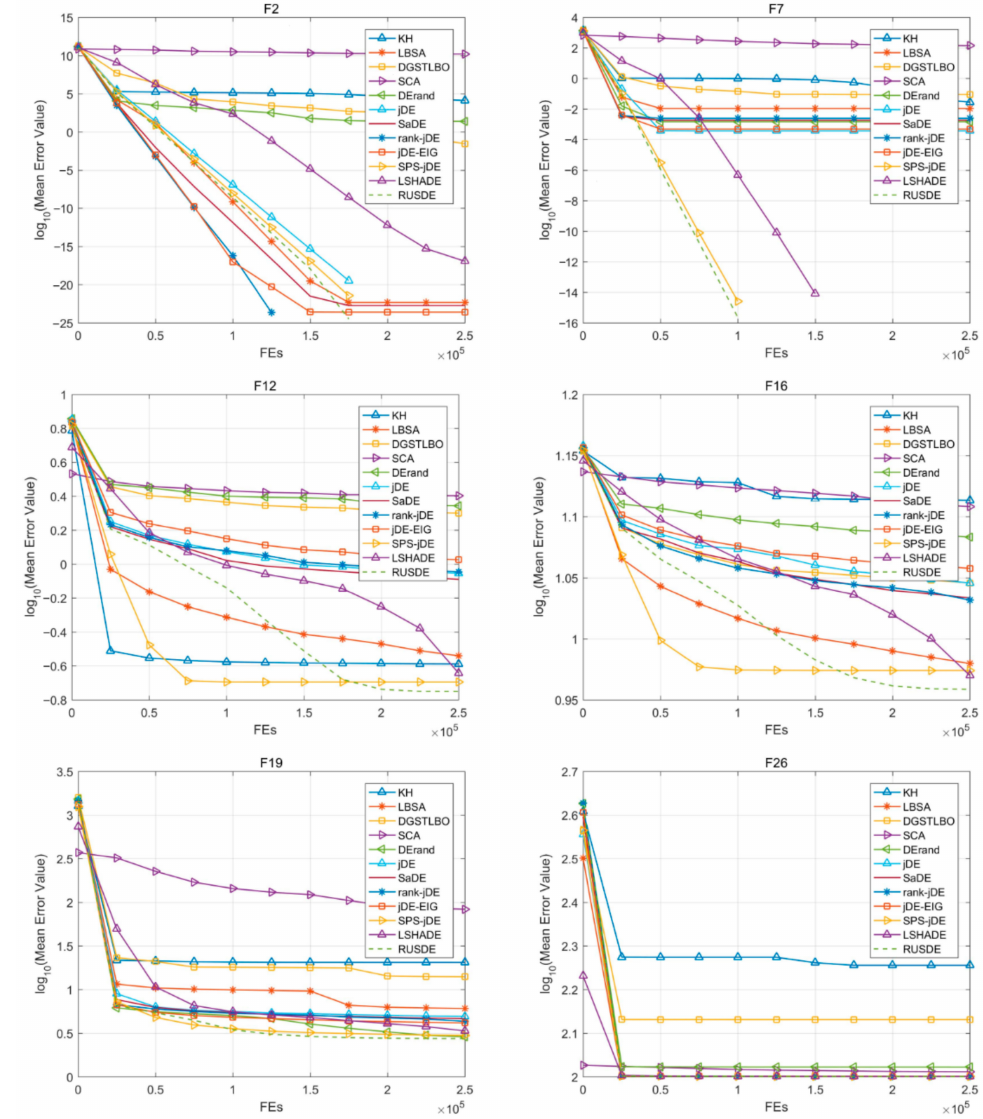
Figure 1. Convergence curves in 30D problems of the CEC 2014